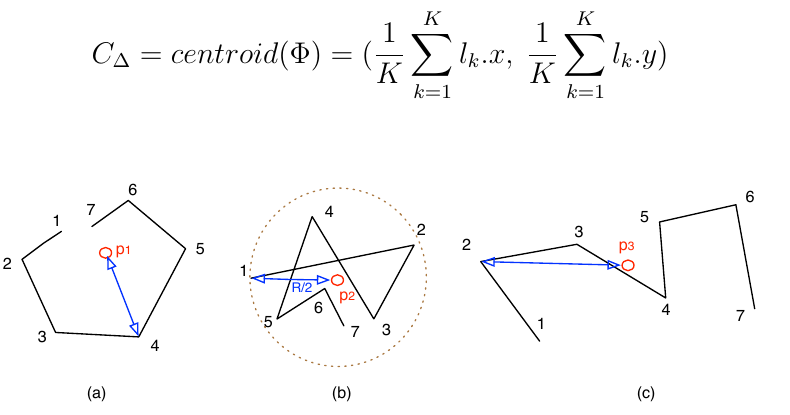
Figure 3. Examples of node trajectories and their activity ranges: ( a ) moving trajectories of node s ; ( b ) moving trajectories of node s 1